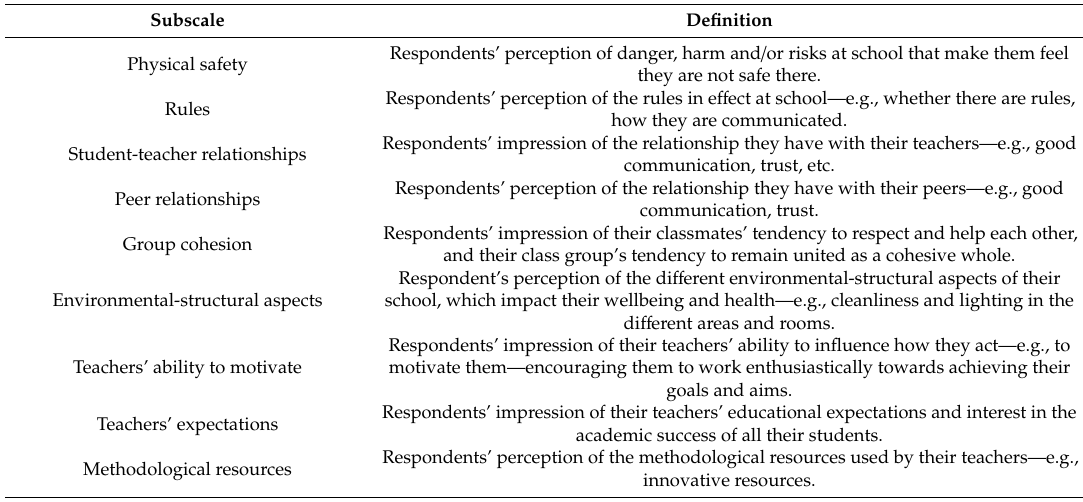
Table 1. Definition of the PACE-33